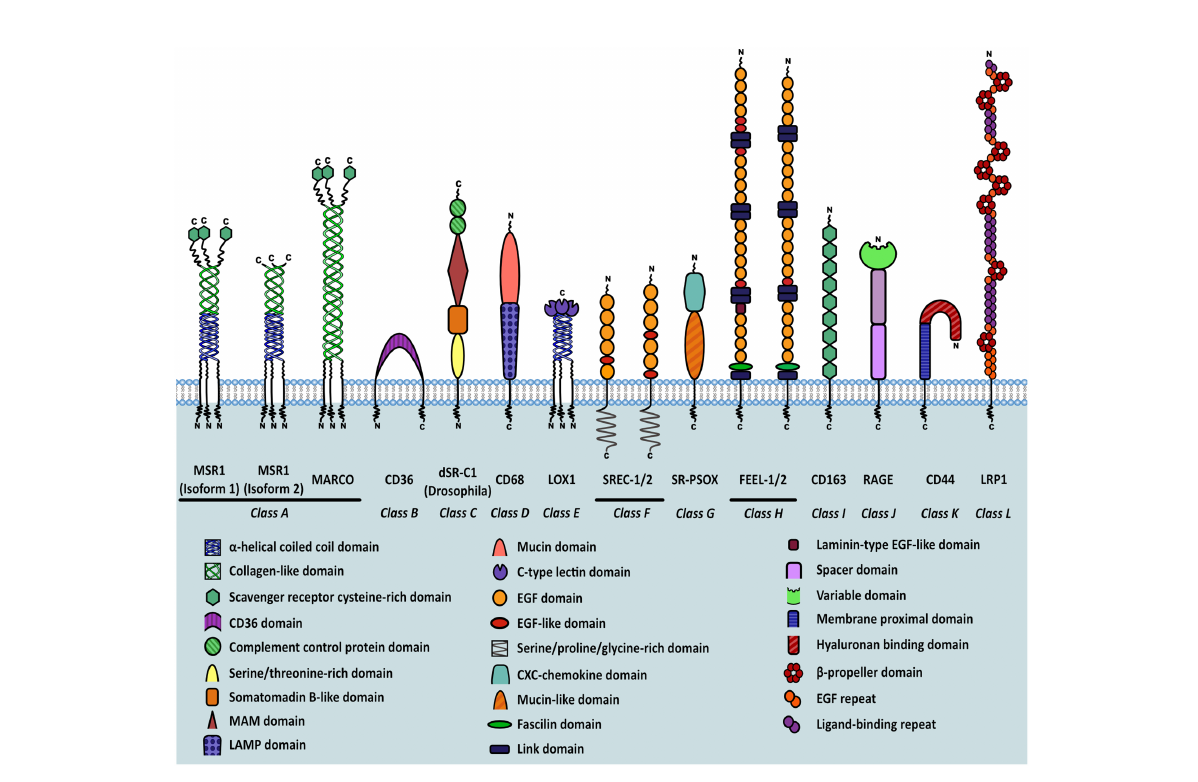
FIGURE 1 Classi fi cation of scavenger receptors and MSR1 isoforms. Schematic representation of different classes of scavenger receptors. Individual domains are identi fi ed in the key within the fi